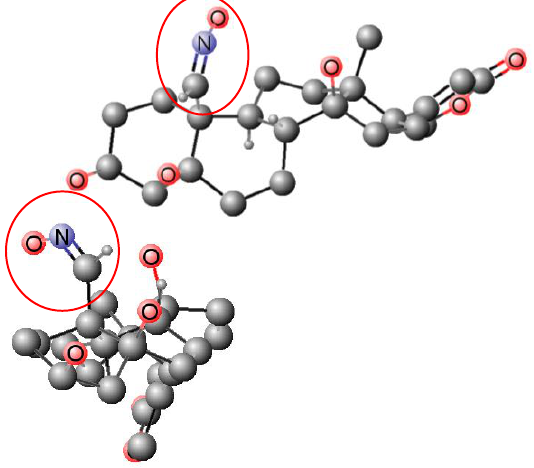
Fig. 5. Z isomer aldoxime